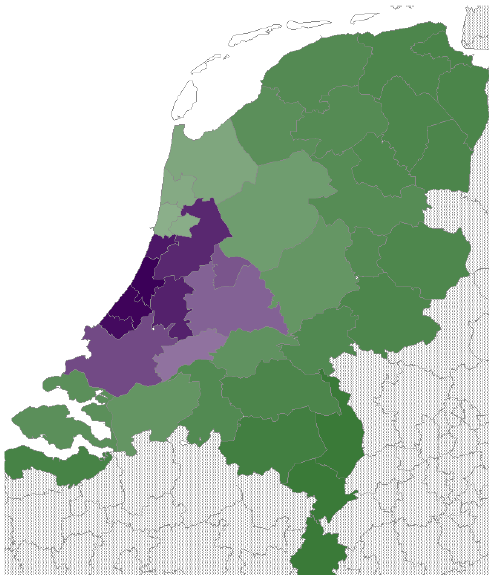
Figure 4. Randstad region (violet) of the